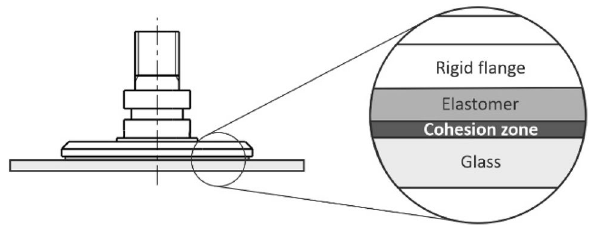
Fig. 20 Composition of the computer model